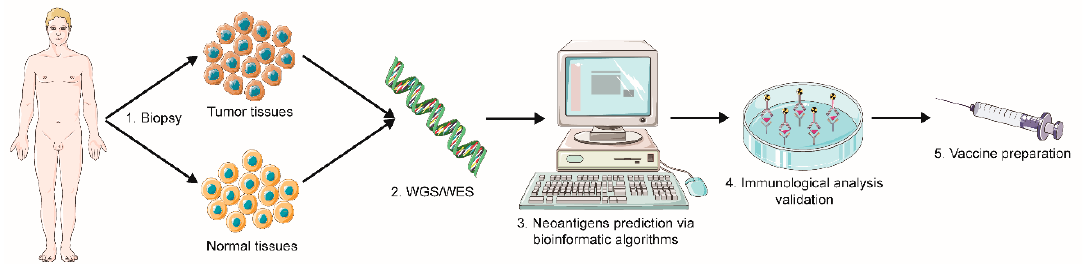
Figure 2. Framework for sequencing and prediction of neoantigens. 1. Biopsy is performed in cancer patients for tumor tissues and corresponding normal tissue. 2. Whole-genome sequencing (WGS)/whole-exome sequencing (WES) is carried out on tumor tissues and normal tissues to verify the somatic mutations expressed in tumor cells. 3. Bioinformatic algorithms are conducted to predict the MHC binding affinity of neoantigens, and the most attractive neoantigens for immune targeting are prioritized as candidates. 4. In vitro and in vivo experiments are used to validate the potential role of selected neoantigens. 5. Final vaccine preparation according to the selection of neoantigens. The figure was produced with the assistance of Servier Medical Art